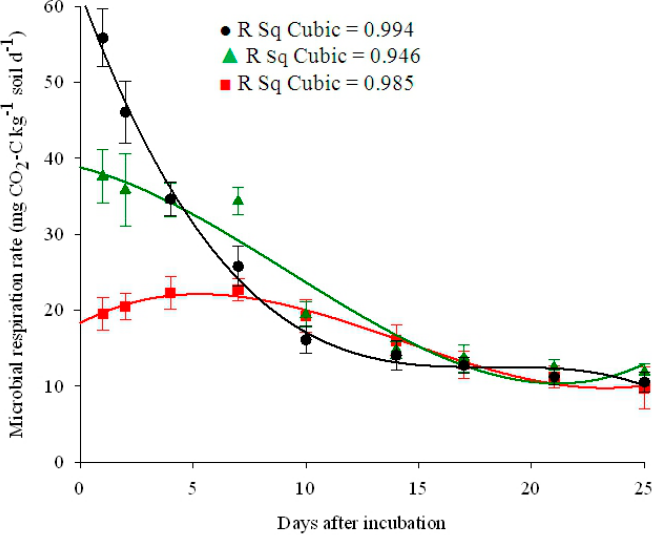
Figure 2. Respiration rate during 25 days of incubation in cereal field ( ■ ), grass-covered vineyard ( ▲ ), and cherry farm ( ● ).